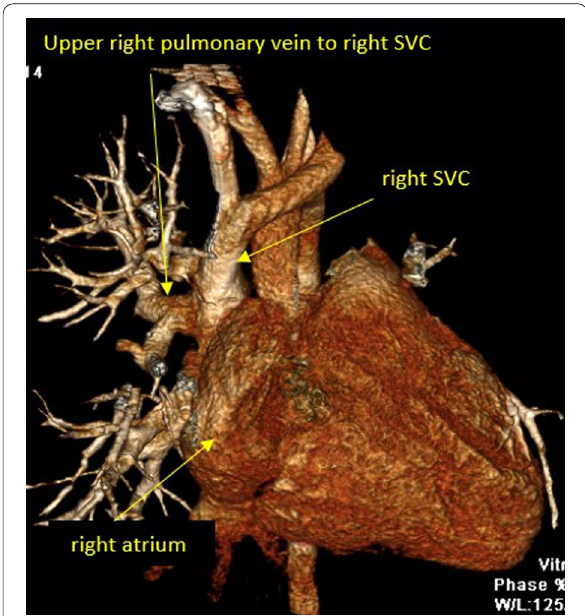
Fig. 2 3D volume rendering image showing partial anomalous pulmonary venous drainage of the upper right pulmonary vein into the right superior vena cava